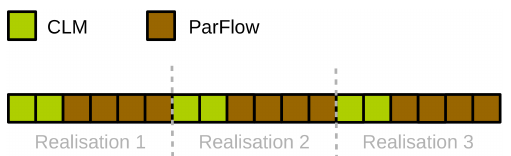
Figure 4. Example of the processor layout of TerrSysMP–PDAF for three model realisations where each realisations is simulated with two processors for CLM and four processors for